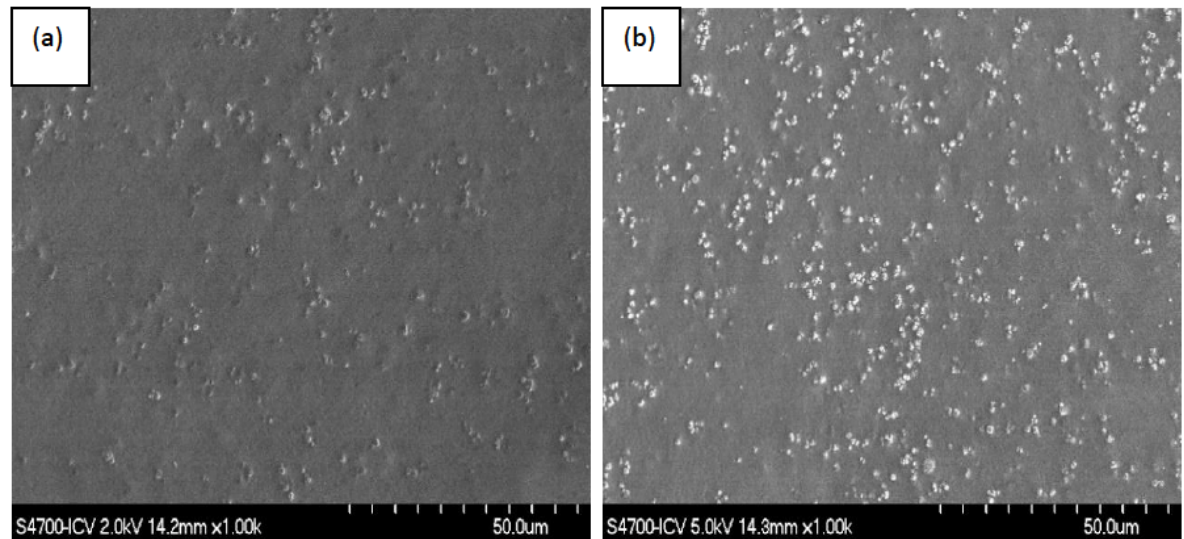
Figure 5: SEM micrographs of MMMs with fillers in different weight proportions, (a) 10wt.% and (b) 20wt.% showing the surface morphol- ogy.